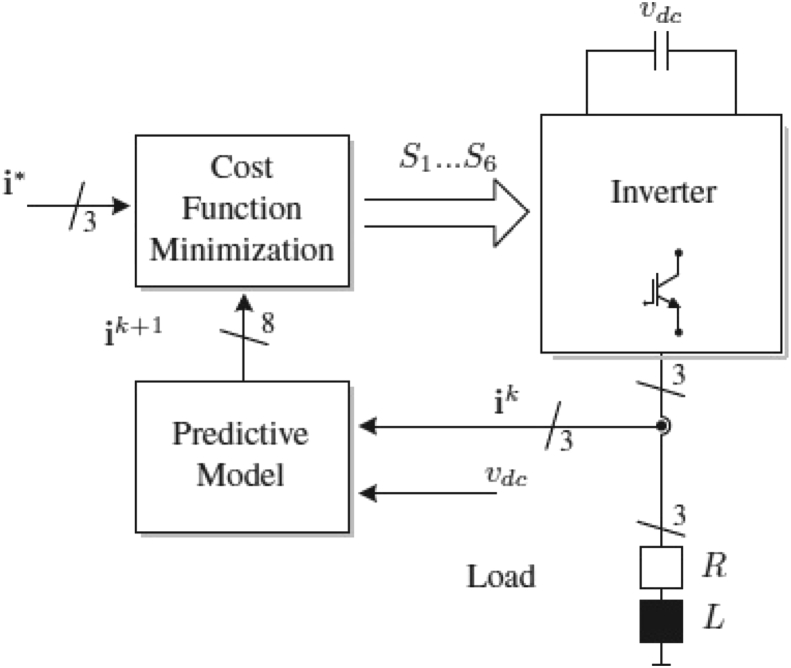
Classic predictive current control method [7].